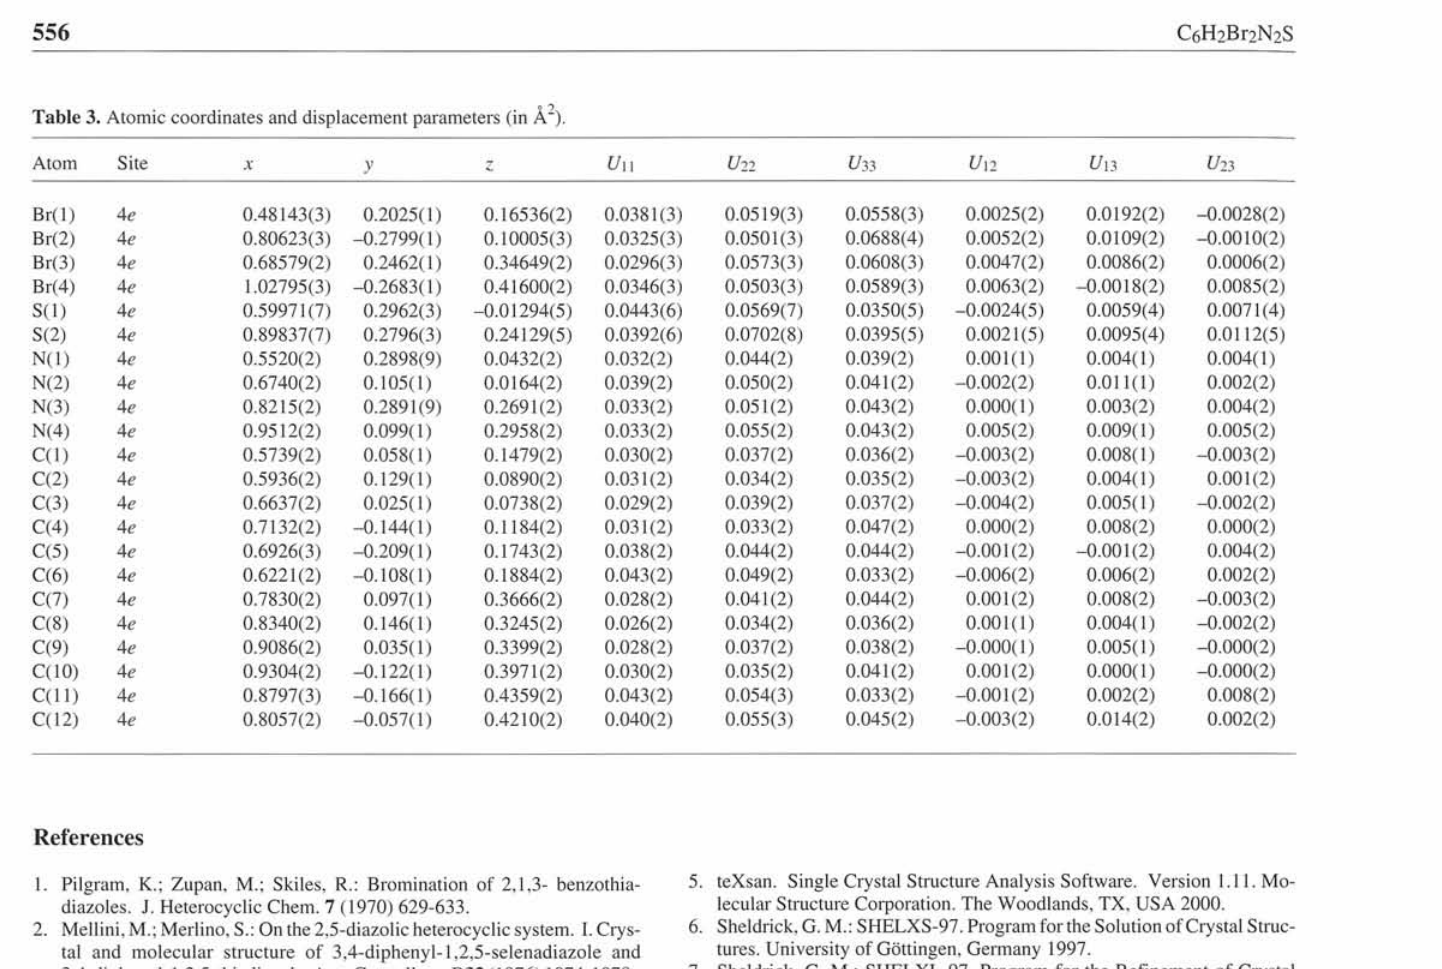
Table 3. Atomic coordinates and displacement parameters (in